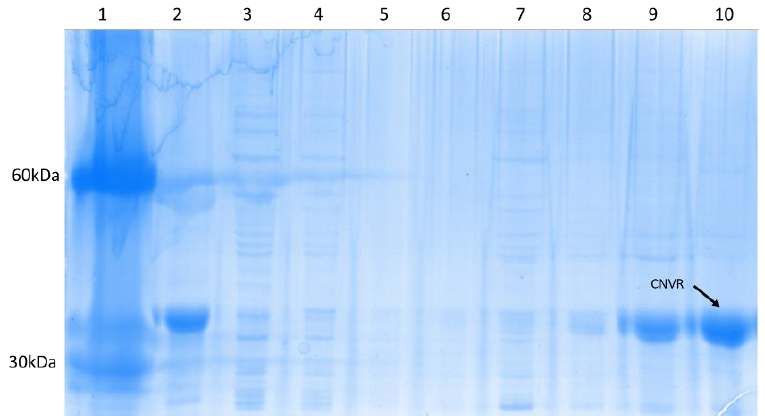
Figure 3. Recombinant Concanavalin (CNVR) Purification. 1 = Molecular marker, 2 = Pellet after expression, 3 = fraction recovered in phosphates buffer, 4–6 = fraction recovered in mercaptoethanol 10 mM, 7–8 = fraction recovered in Urea 1 M, 9–10 = fraction recovered in urea 6 M.